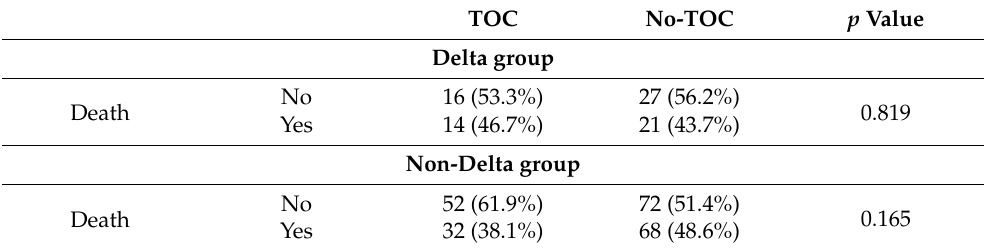
Table 4. Death n (%) in Delta and non-Delta patients treated or not with tocilizumab (TOC, no-TOC); Fisher’s exact test was